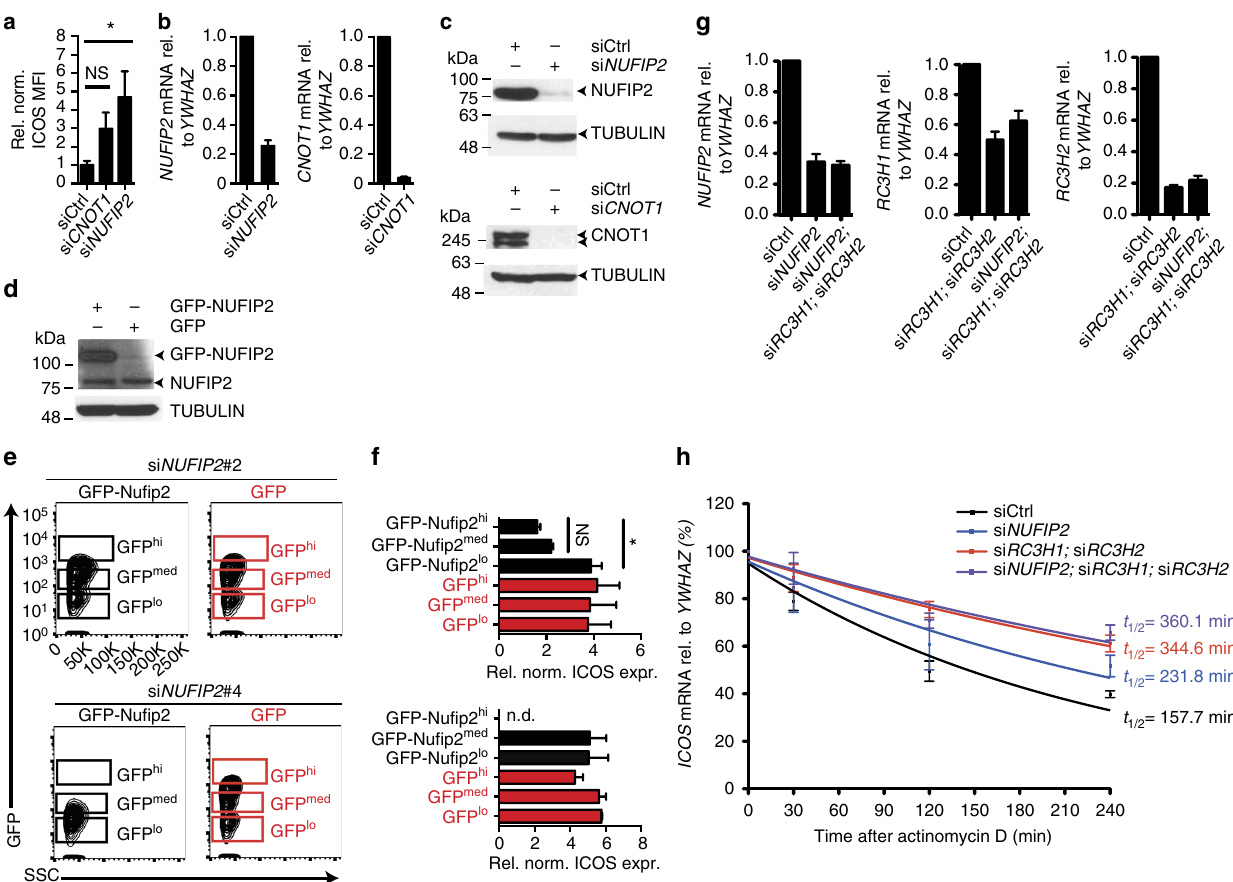
Fig. 3 ICOS repression by NUFIP2 depends on Roquin expression. a MFI of ICOS expression or b qPCR analysis of NUFIP2 and CNOT1 relative to YWHAZ mRNA expression after siRNA knockdown of NUFIP2 or CNOT1 in HeLa reporter cells using siGENOME siRNA pools. c Immunoblot analysis of NUFIP2 and CNOT1 expression in HeLa reporter cells after treatment with the siGENOME NUFIP2 or CNOT1 siRNA pool, respectively. d Immunoblot analysis of NUFIP2 expression in reporter cells that were transduced with GFP- or GFP-NUFIP2 by retroviral infection. e Flow cytometry analysis of GFP expression in HeLa reporter cells that were transduced with different amounts of GFP- or siRNA-resistant GFP-NUFIP2 by retroviral infection. f GFP- or siRNA-resistant GFP- NUFIP2-expressing reporter cells from e were transfected with NUFIP2 -targeting or control siRNAs and Roquin expression was induced with doxycycline. ICOS expression was measured by fl ow cytometry and normalized to siCtrl-treated cells. ICOS expression in cells with high (hi) or intermediate (med) GFP-expression is compared with that of low (lo) GFP-expressing cells. g qPCR analysis of NUFIP2 , RC3H1 , and RC3H2 mRNA expression in HeLa reporter cells after transfection with the indicated siRNAs. Expression relative to the reference gene YWHAZ was normalized to the non-targeting control. h ICOS mRNA decay curves of HeLa reporter cells after treatment with the siGENOME NUFIP2 -targeting siRNA pool, a combination of siRNAs against RC3H1 and RC3H2 (Invitrogen) or a combination of all three targets or a non-targeting control siRNA. Forty-eight hours after transfection, cells were seeded for treatment with 5 µ g/mL actinomycin D the next day. Cells were treated for 30 – 240 min and ICOS expression was determined by qPCR analysis and normalized to YWHAZ . In c and e representatives of three independent experiments are shown. Error bars in a , b , d , f , g , and h represent mean and SDs of three ( a , b , f , g ) or four ( d , g , h ) independent experiments. mRNA half-life in h was calculated with Graph Pad Prism from four independent experiments. In a and f statistical signi fi cance was calculated with one-way ANOVA Kruskal − Wallis test followed by Dunn ’ s multiple comparisons test (* p <